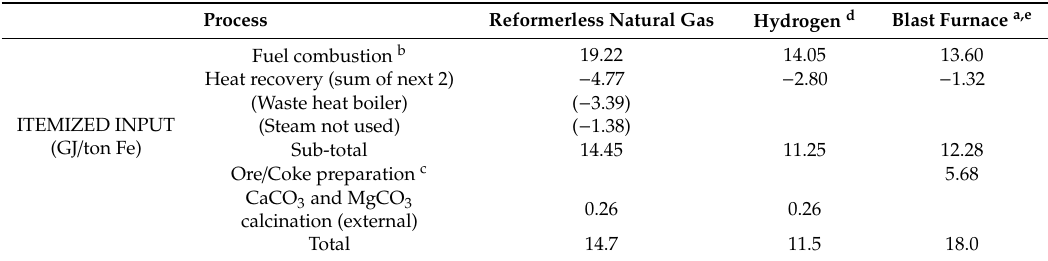
Table 3. Energy input for an industrial-scale flash ironmaking process using natural gas or hydrogen vs. an average blast furnace process (for production of 1 million tons of iron). (Adapted from Pinegar et al. [20,21]).